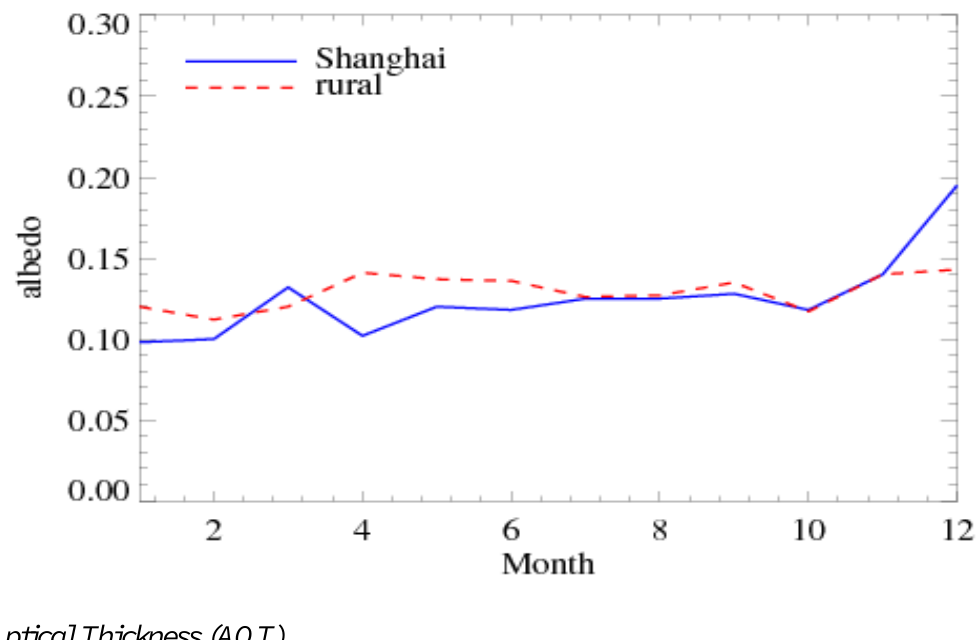
Figure 7. Monthly averaged albedo in 2004, where the solid line represents Shanghai and the dashed line represents